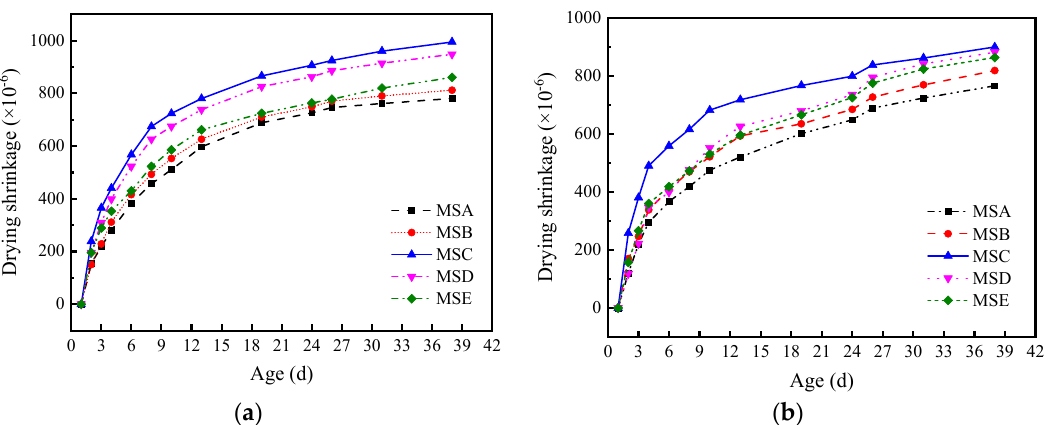
Figure 23. Drying shrinkage strain of concrete with different manufactured sand: ( a ) mix proportion